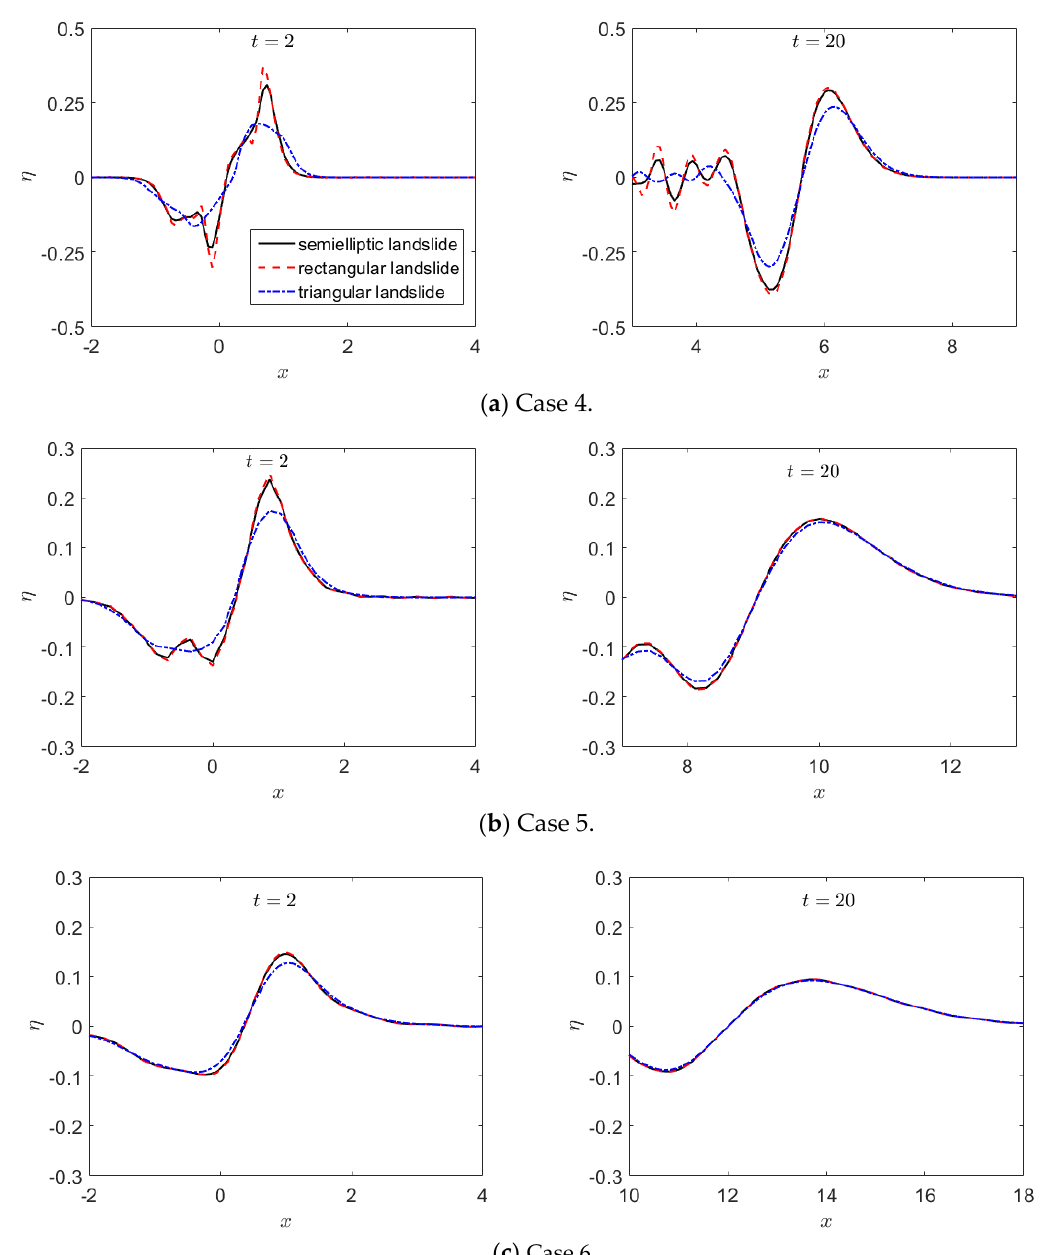
Figure 4. Comparisons of water waves generated by landslides with three different shapes ( Fr = 0.375, LFD model).